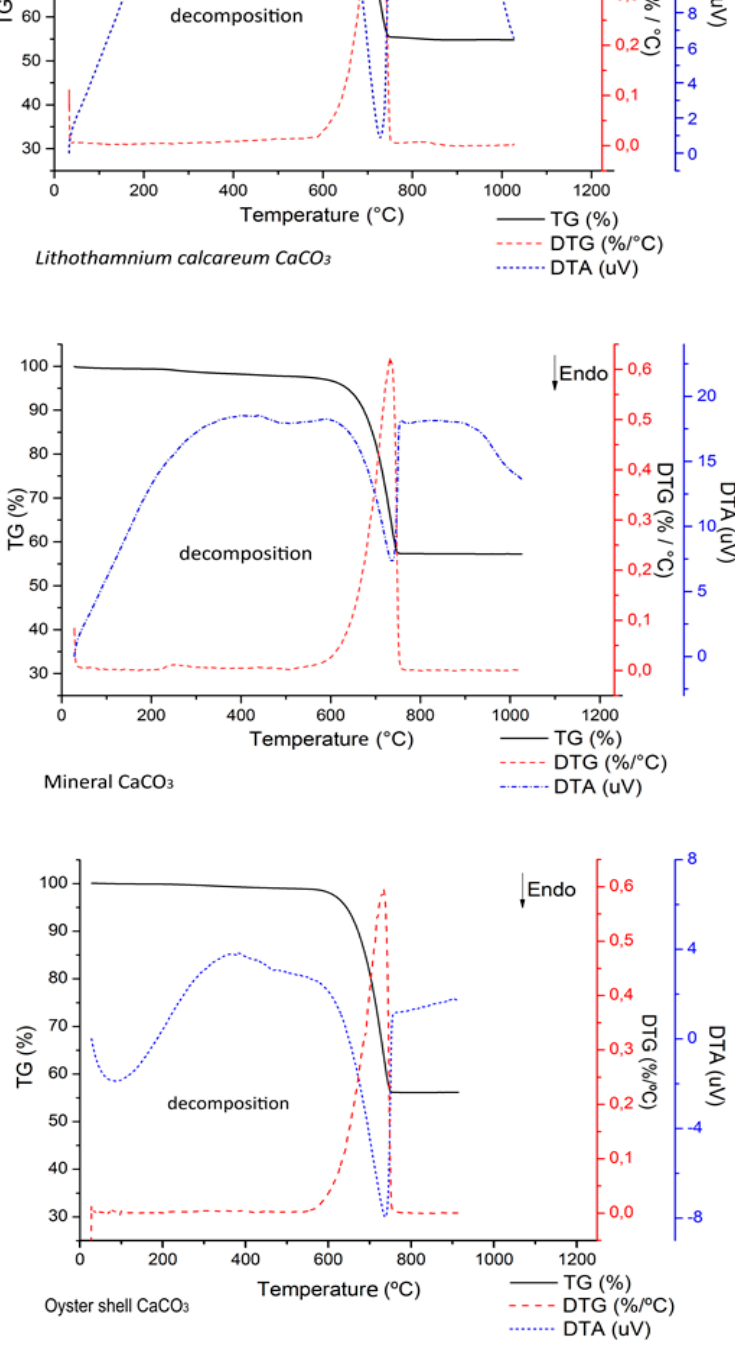
Figure 2. Thermogravimetry (TG) and DTG profiles of L. calcareum , inorganic mineral and oyster shell CaCO 3 .